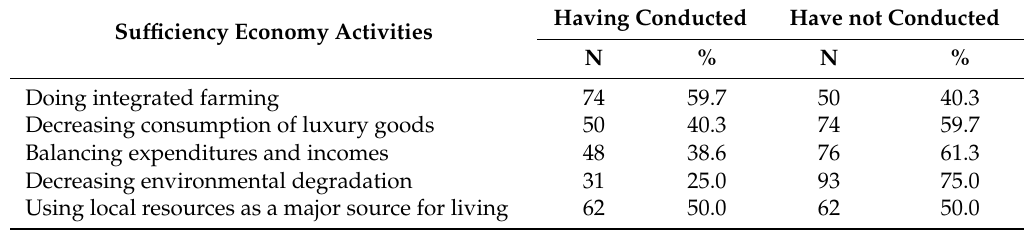
Table 2. Sufficiency economy activities conducted by villagers in the Ban Jamrung